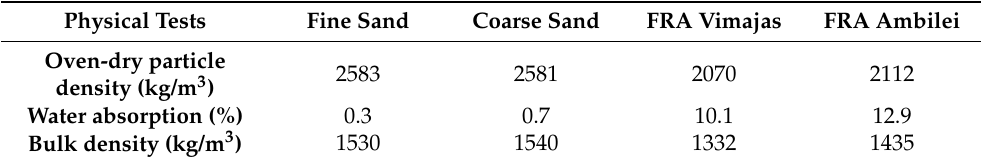
Table 3. Results of the physical tests of the fine aggregates.